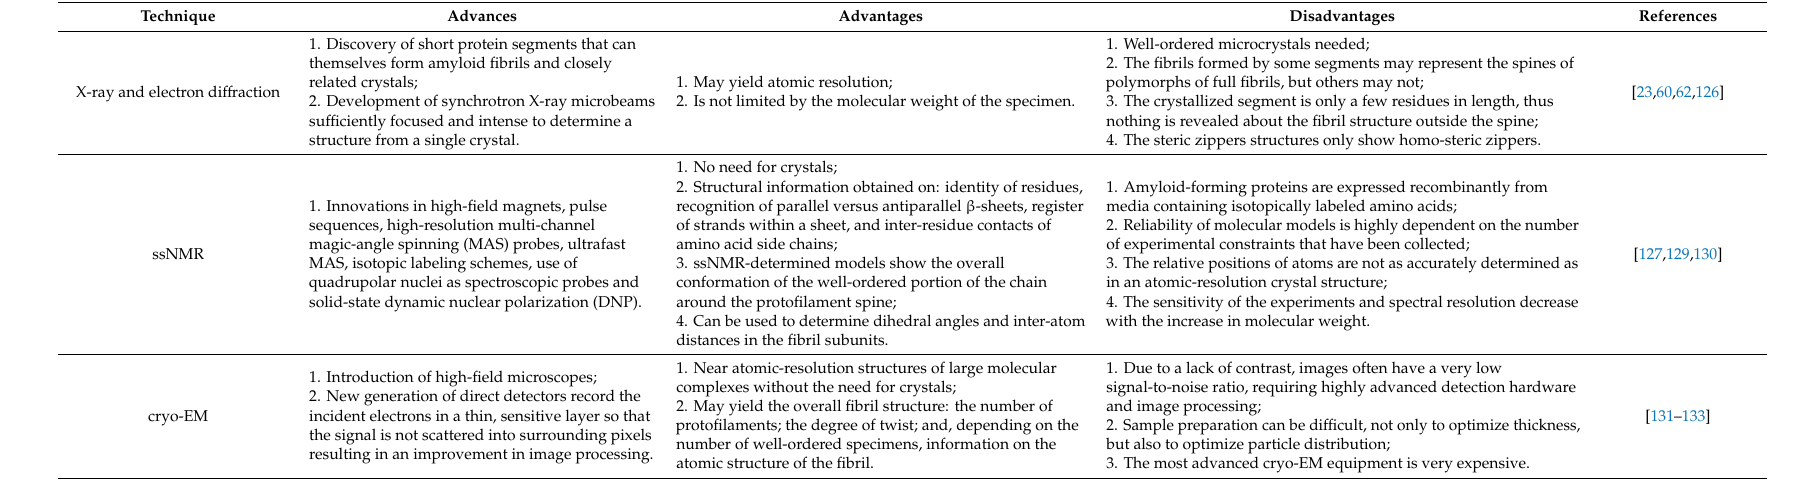
Table 3. The pros and cons of the main methods that inform on amyloid structure at atomic level